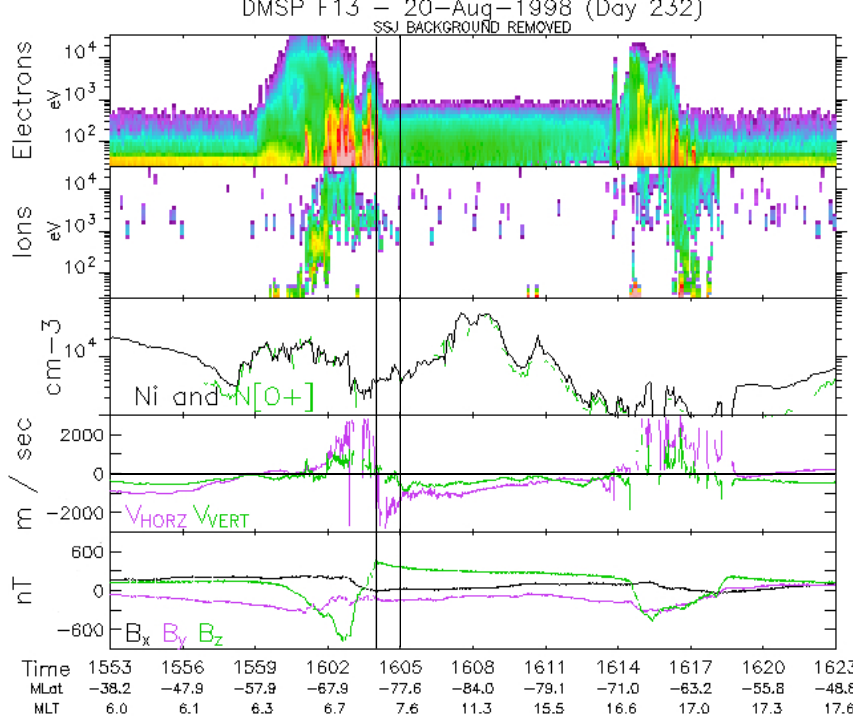
Fig. 10. Southern Hemisphere DMSP F13 data for the interval 15:53–16:23UT. Cross track ion drift (panel 4) is shown in the context of particle precipitation (panels 1 and 2) and Birkeland current regimes ( B z trace in bottom panel). Flow channel FC 2 in panel 4 is marked by vertical guidelines. Event category: SH-dawn/ B y < 0